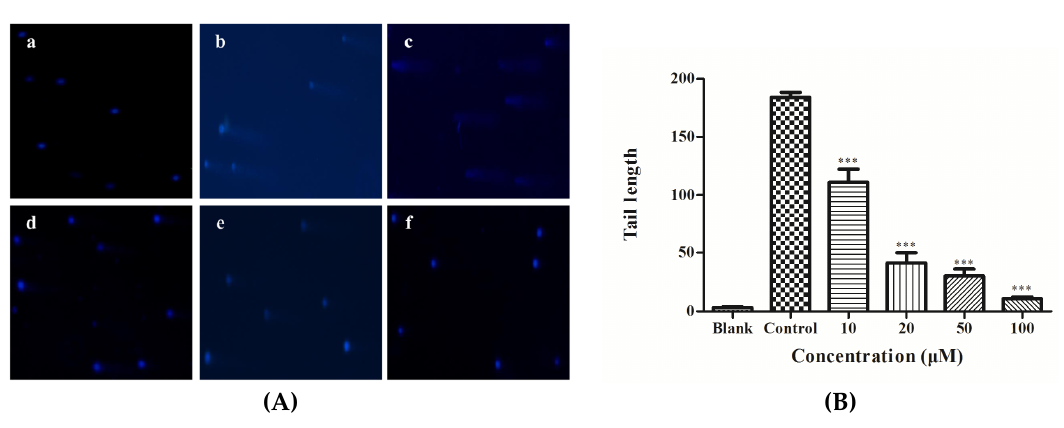
(B) Figure 7. ( A ) Effect of YGDEY on the MAPK signaling pathway in HepG2 cells. Cells were pretreated with YGDEY (10, 20, and 50 μM) for 24 h before induction by 0.75 M ethanol for 2 h. β-Actin was used as an internal control. ( B ) Relative protein expression was normalized. Data are